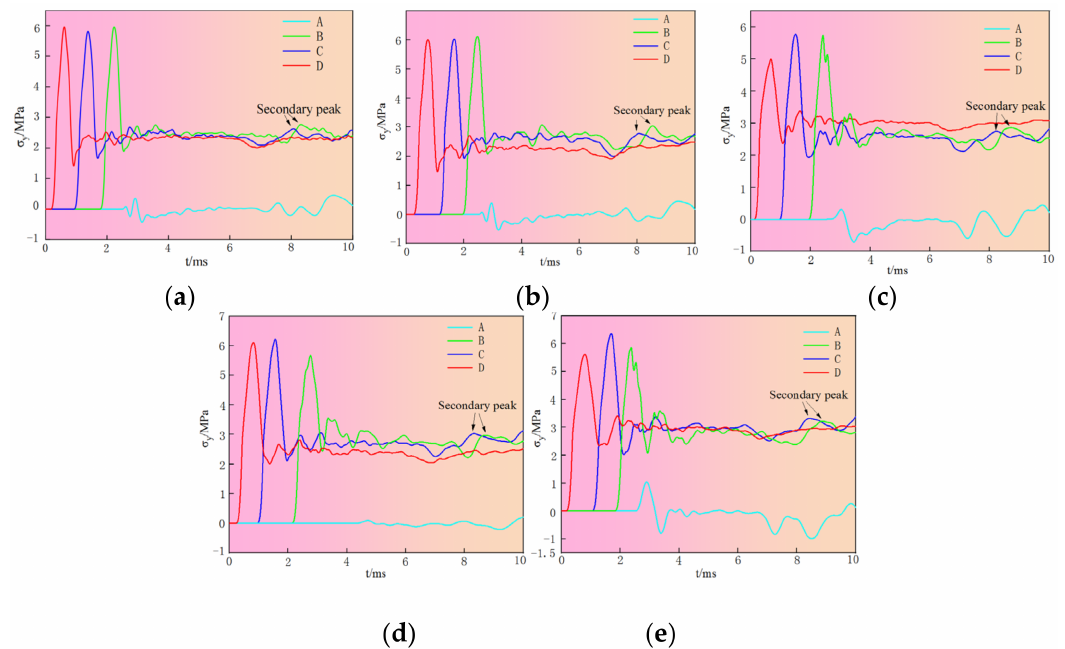
Figure 14. Y-direction stress–time history curves of each aperture and its 7 times aperture dis- tance. ( a ) 90 mm aperture. ( b ) 100 mm aperture. ( c ) 110 mm aperture. ( d ) 120 mm aperture. ( e ) 130 mm